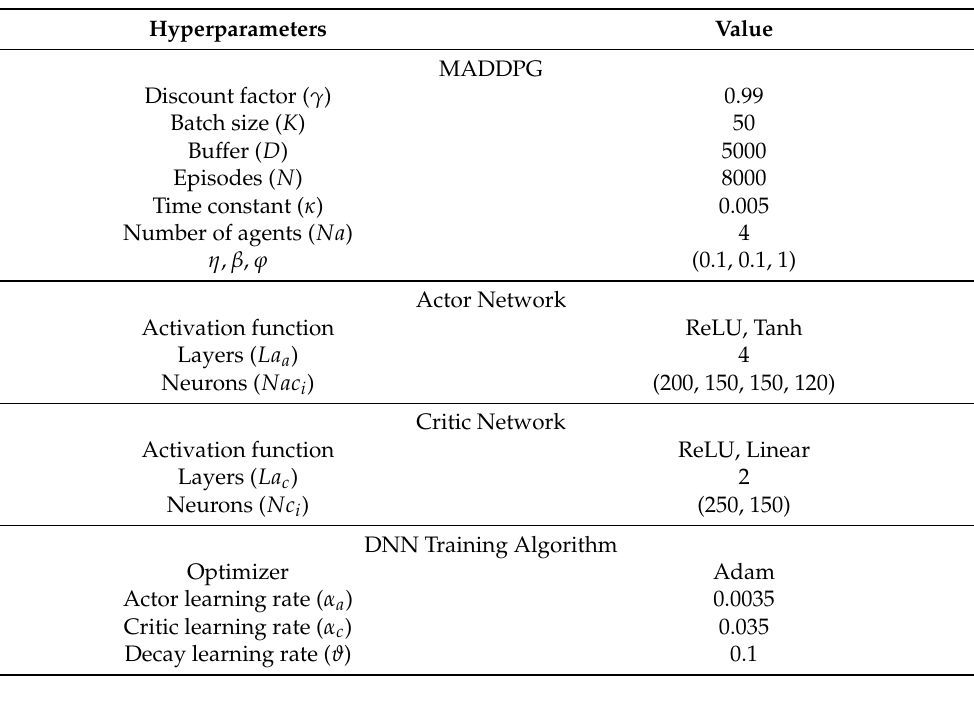
Table 2. The MADDPG algorithm’s hyperparameters.